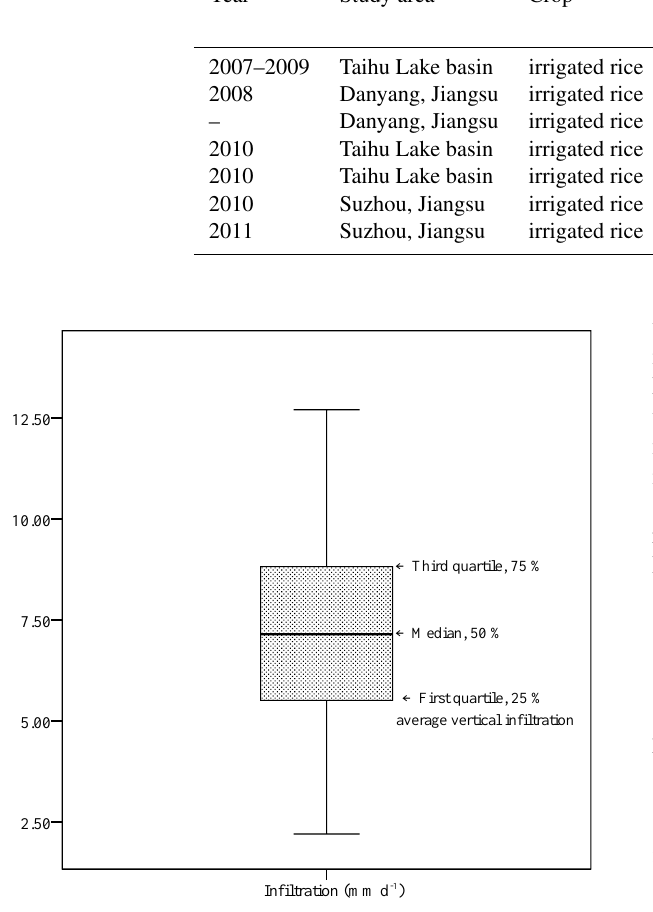
Figure 3. The box and whisker plot of infiltration of the paddy